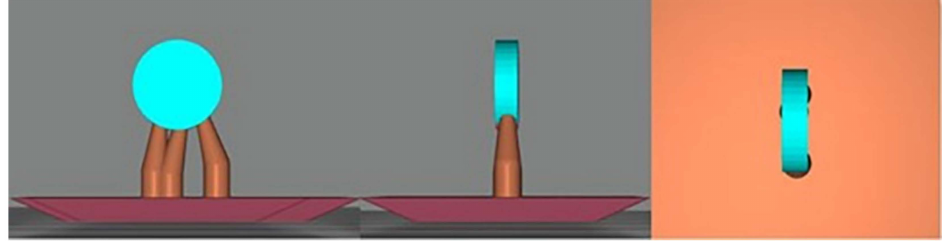
Figure 2. CAD design of the VP additive-manufacturing dental resin sample with 90 ◦ printing orientation (Meshmixer v. 3.5, Autodesk, Inc., CA,